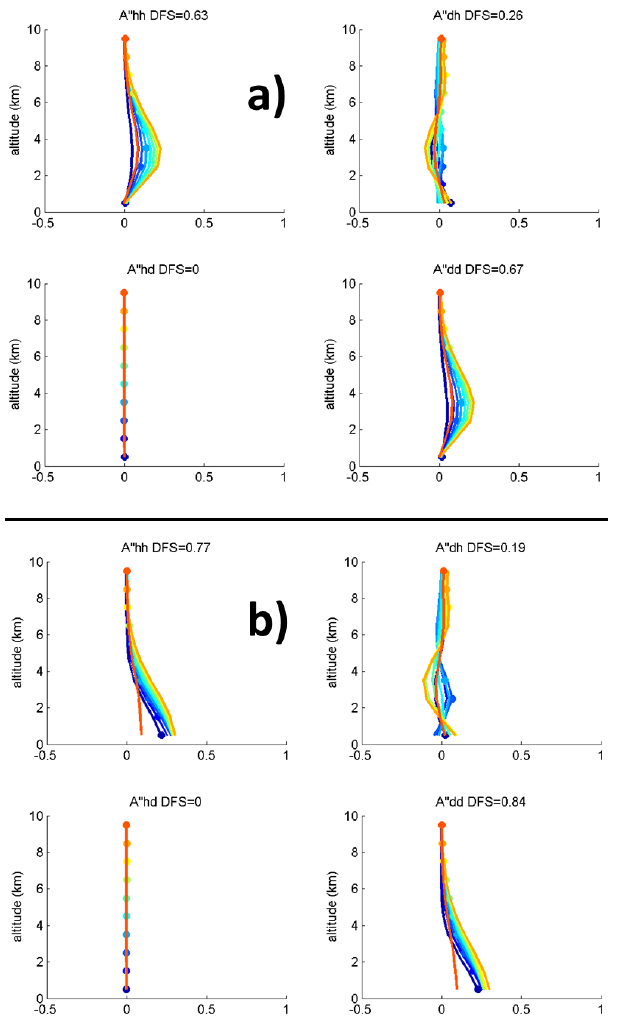
Figure 6. As Fig. 5, for A 00 , representing the { humidity, proxy- δ D } state.